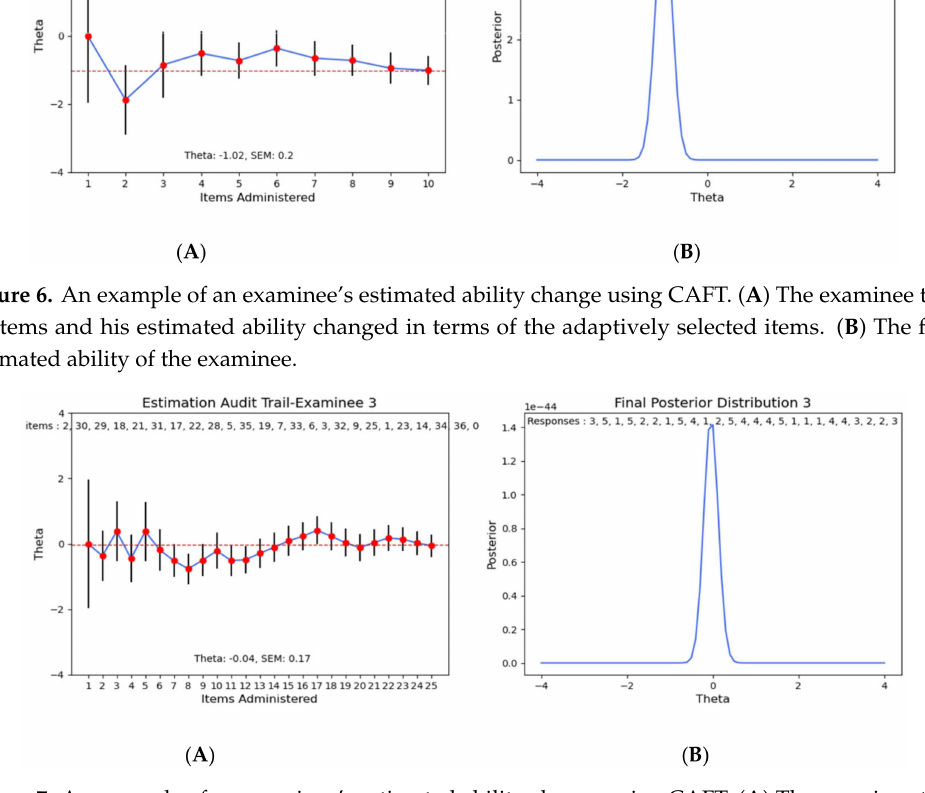
Figure 7. An example of an examinee’s estimated ability change using CAFT. ( A ) The examinee took 25 items and his estimated ability changed in terms of the adaptively selected items. ( B ) The final estimated ability of the